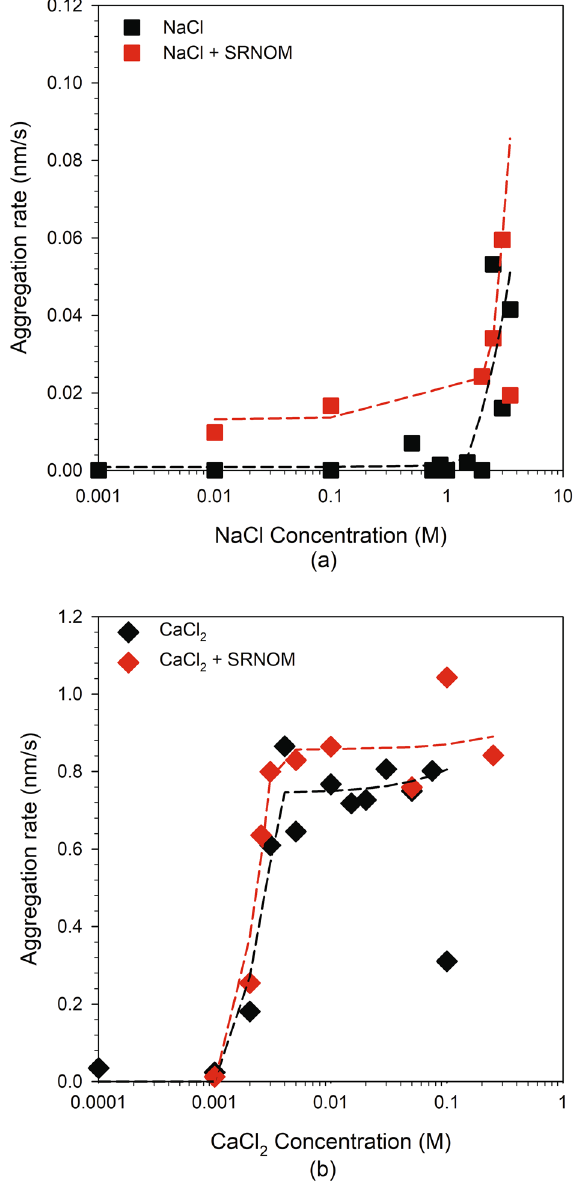
Fig. 8 Aggregation rates of QDs suspended in aqueous chloride salt solutions as a function of the types and concentrations of elec- trolytes and the absence and presence of the SRNOM at 10 mg/L: a Monovalent electrolyte NaCl in both the absence and presence of the SRNOM at 10 mg/L, b Divalent electrolyte CaCl absence and presence of the SRNOM at 10 mg/L